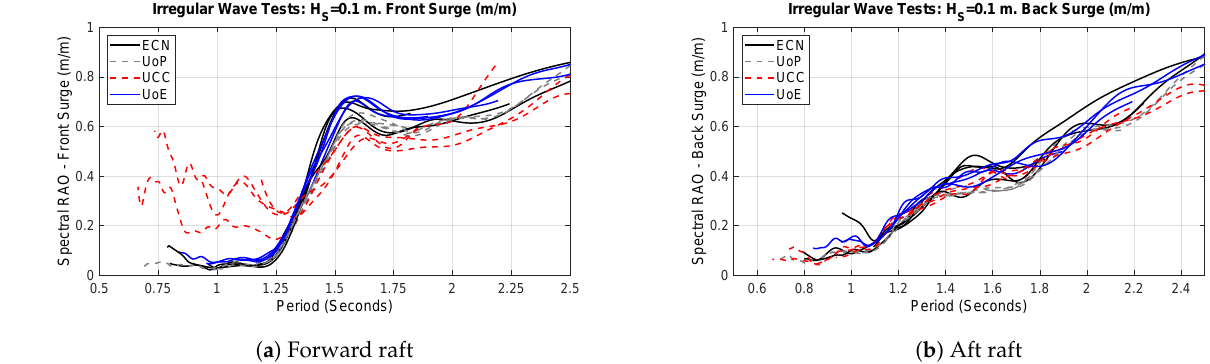
Figure 12. Surge RAO for H s of 0.1 m across facilities.